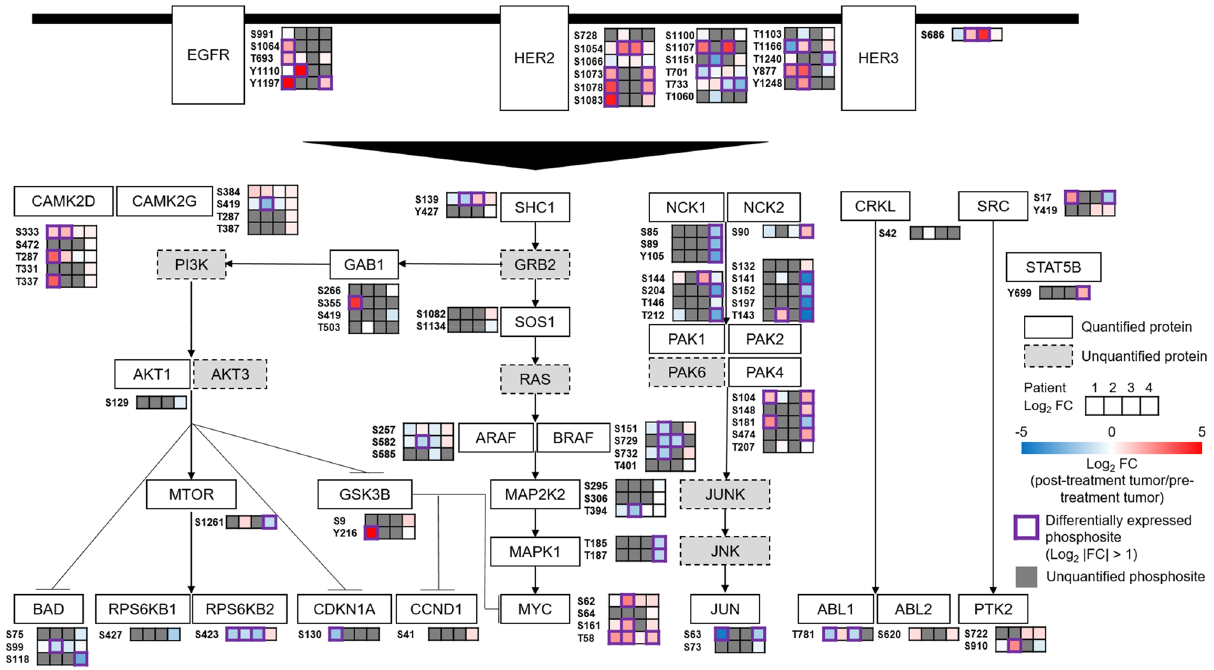
Figure 5. Individual comparison of phosphorylation status between pre- and post-treatment HER2-positive gastric cancer. Proteins in the ErbB signaling pathway are selected from the KEGG database 65 . Proteins with quantified phosphosites are shown as white boxes with solid lines. Proteins without quantified phosphosites are shown as grey boxes with dotted lines. Differentially expressed phosphosites (log 2 |FC| > 1) are depicted by a purple line. Phosphosites with no quantitative value are filled with